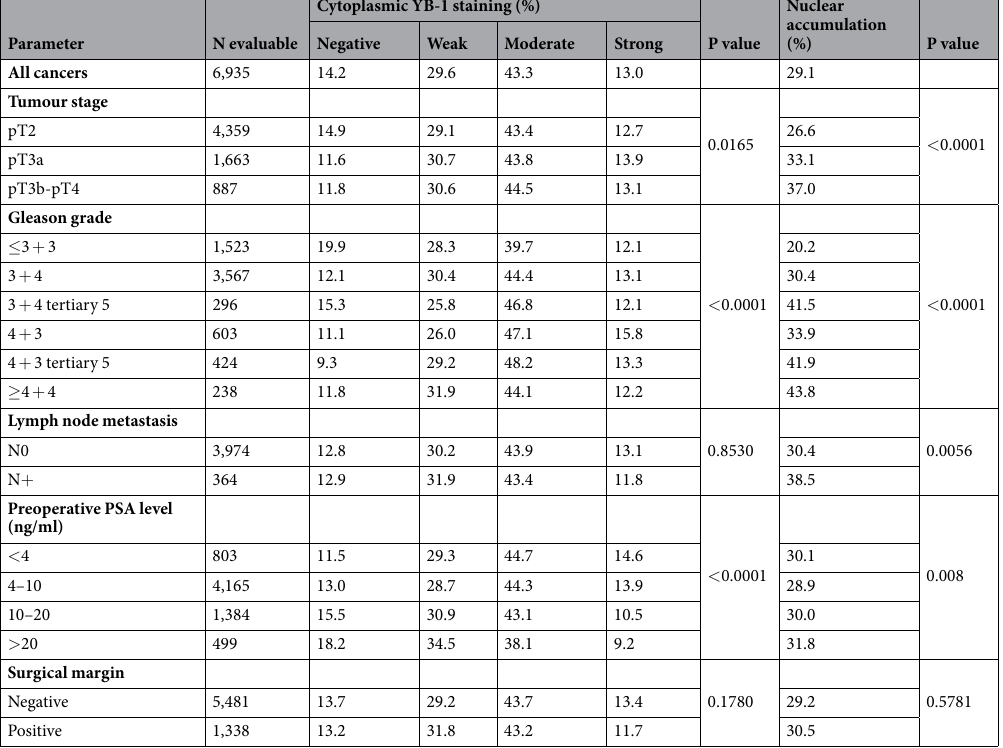
Table 1. Association between YB-1 staining results and prostate cancer phenotype.